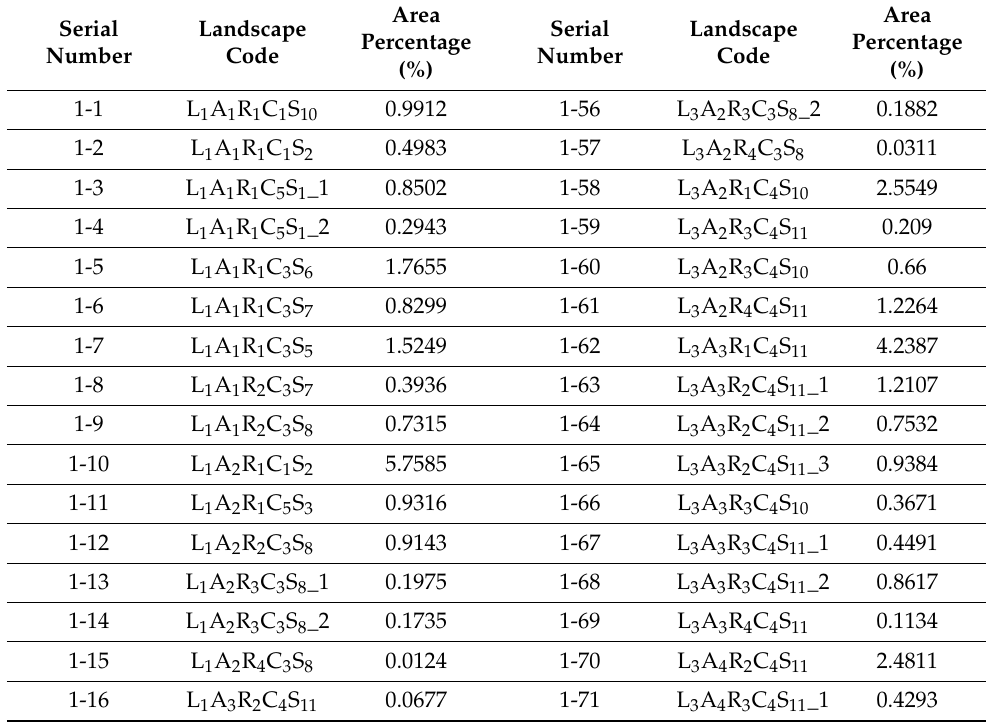
Table A3. Nomenclature of 1 km * 1 km scale